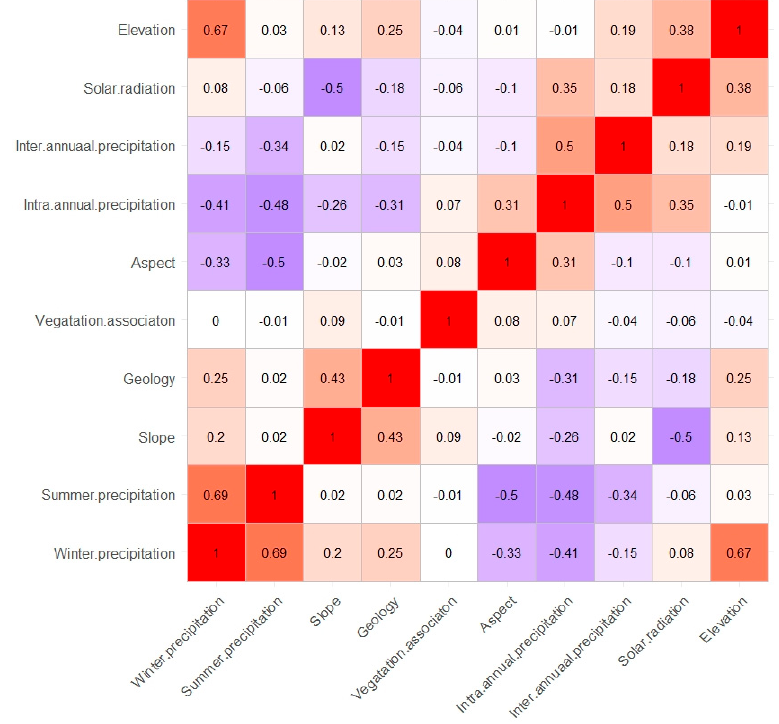
Figure A3. Pearson correlation coefficients of environmental raster used in ecological niche modelling (ENM).